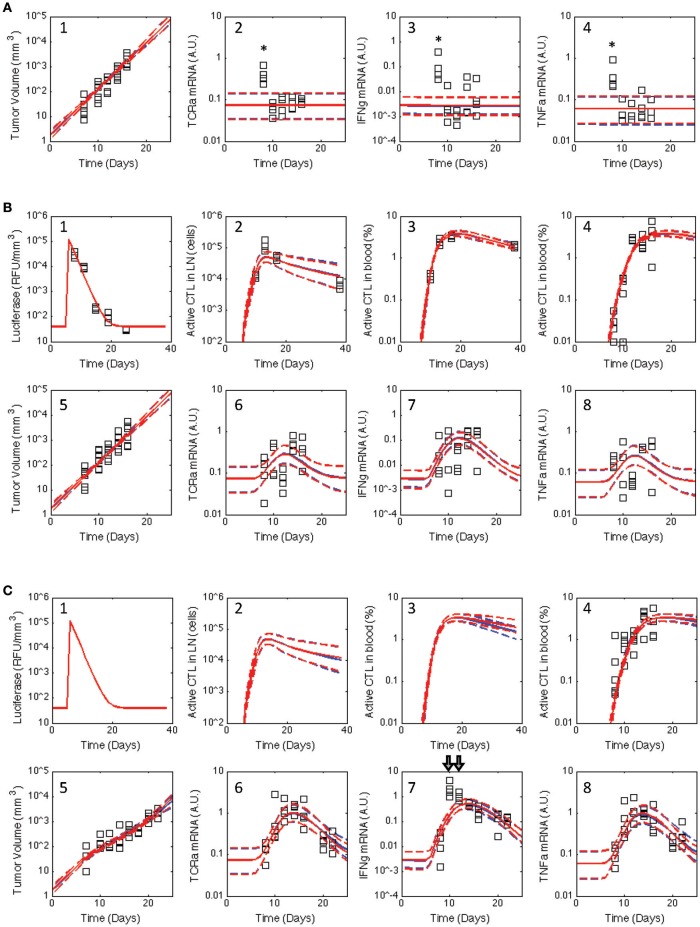
Posterior distribution in the model predictions obtained for the V2 and V3 models compared against the observed data for all three treatment groups. Similar to Figure 2, the experimental data (squares) acquired for untreated C57Bl/6 mice (A) and mice immunized with rHuAd5-hgp100 (B) and rHuAd5-hDCT (C) adenovirus expression vector on day 5 following B16F10 implantation were compared to the posterior distributions in the model predictions obtained using the V2 (red curves) and V3 (blue curves) models. Experimental observations shown in each subpanel include antigen expression (luciferase expression: B-1,C-1), activated CD8+ T cells in lymph node (B-2,C-2), activated CD8+ T cells in blood (percent of total CD8+ T cells: B-3,B-4,C-3,C-4), tumor volume (A-1,B-5,C-5), TCRa mRNA expression in tumor (A-2,B-6,C-6), IFNG mRNA expression in tumor (A-3,B-7,C-7), and TNFα mRNA expression in tumor (A-4,B-8,C-8). The model predictions are represented by a solid line, which represents the median response, and dashed lines that enclose the 95% credible interval. As they were considered outliers, experimental values excluded from the analysis are indicated by *. Luciferase, active CD8+ T cells in lymph node, and activated CD8+ T cells in blood are not shown for untreated C57Bl/6 mice as they are essentially zero.